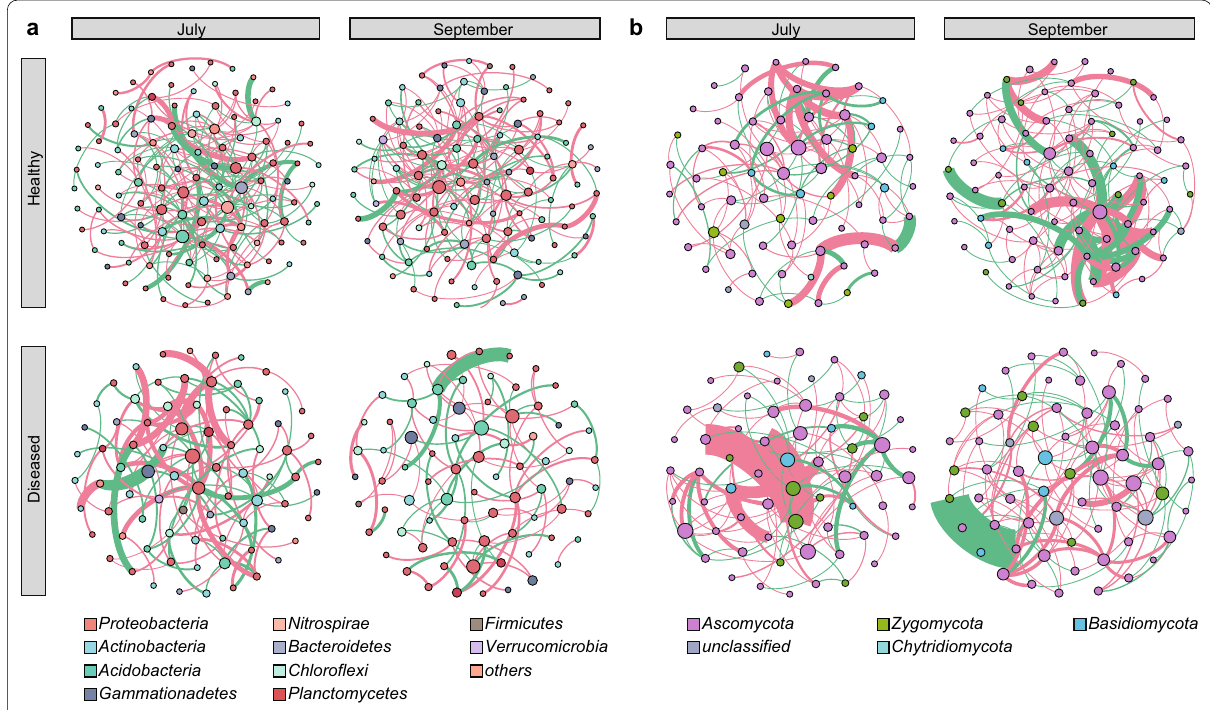
Fig. 5 Co-occurrence patterns of a bacteria and b fungi in healthy and diseased rhizosphere samples. Nodes indicate taxonomic affiliation at phylum level. Red lines indicate positive correlations, and green lines indicate negative correlations. The size of each node is proportional to the betweenness centrality. Detailed properties of network indices were listed in Additional file 1: Table